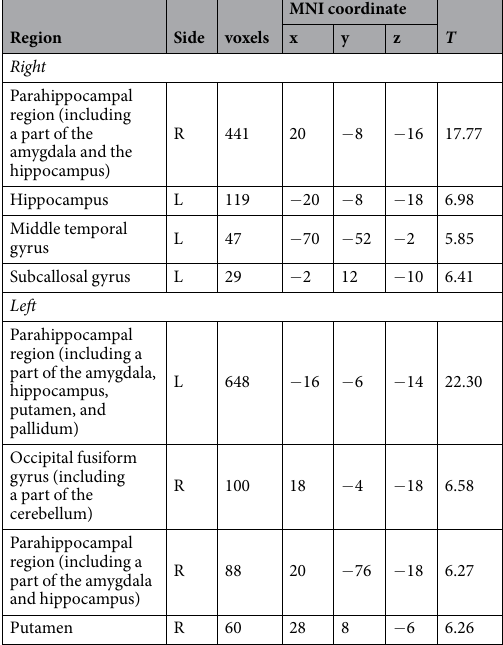
Region Side voxels